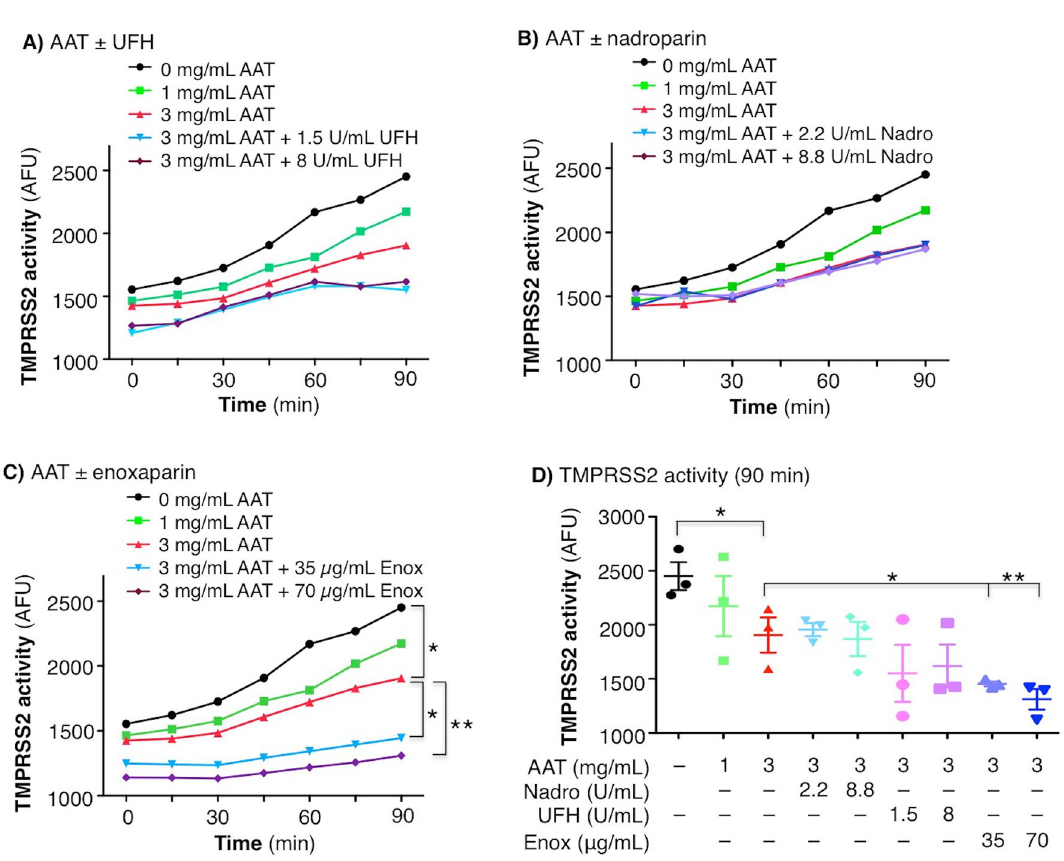
Figure 3. Activity of TMPRSS2 in the presence of AAT alone or with UFH, nadroparin, or enoxaparin. HEK293T TMPRSS2 cells were pre-treated with AAT alone at the indicated concentrations or with ( A ) UFH, ( B ) nadroparin (Nadro), or ( C ) enoxaparin (Enox) at the indicated final concentrations for 30 min, followed by addition of the fluorescent substrate Boc-QAR-AMC. Fluorescence was measured immediately on the fluorescent plate reader and then every 15 min for a total of 90 min. ( D ) TMPRSS2 activity at 90 min in untreated cells and cells incubated with AAT ± two concentrations of nadroparin, UFH, and enoxaparin. Data shown are the triplicate means ± SEM of three independent experiments. *p < 0.05, **p < 0.01 at 90 min. Unfractionated heparin =